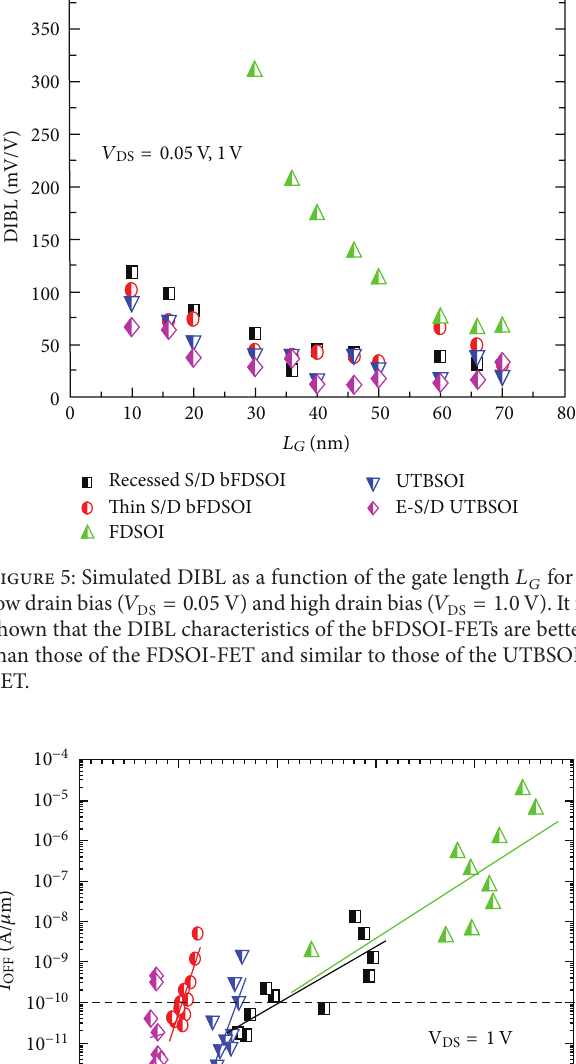
Figure 6: Simulated 𝐼 1.0 V. Mainly due to improved subthreshold swing, bFDSOI-FETs produce higher on/off current ratio than FDSOI-FET.